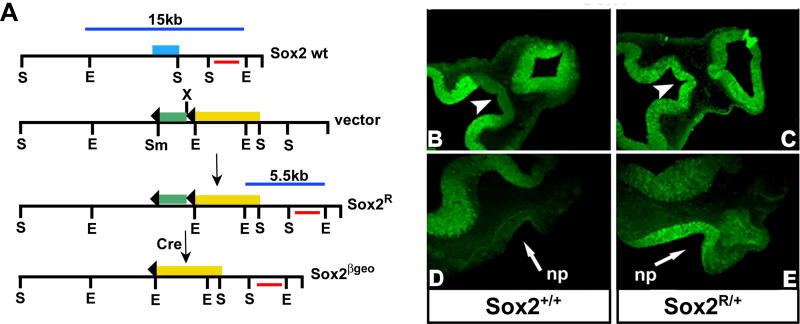
The Sox2
R Allele Delivers SOX1 in Sox2-Specific Expression Sites(A) Strategy for targeted replacement of the SOX2 coding region with that of SOX1 and IRES-βgeo. Restriction enzymes: S, SalI; E, EcoRI; Sm, SmaI; X, Xho. Green boxes indicate Sox1; black arrowheads indicate LoxP sites; yellow boxes indicate IRES βgeo; blue lines indicate fragments appearing in Southern blots of EcoR1-digested genomic DNA, hybridized with the external probe, which is shown with red lines. Black arrows show the locus after recombination, homologous and Cre-mediated where is indicated.(B–E) SOX1 immunostaining of frontal sections from E10 embryos. (B and D) Sox2+/+ and (C and E) Sox2
R/+ showing the ectopic expression of SOX1 in the diencephalon (arrowheads) and the nasal pit (np) at E13.